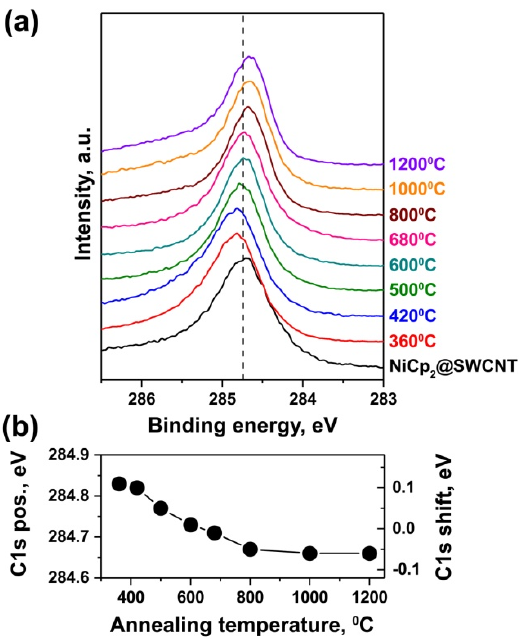
Figure 1. ( a ) The C1s XPS spectra of nickelocene-filled SWCNTsand samples annealed at temperatures between 360 and 1200 ◦ C for 2 h. ( b ) The dependence of the position of the C1s peak and its shift relative to the position for unannealed sampleson annealing temperatures.